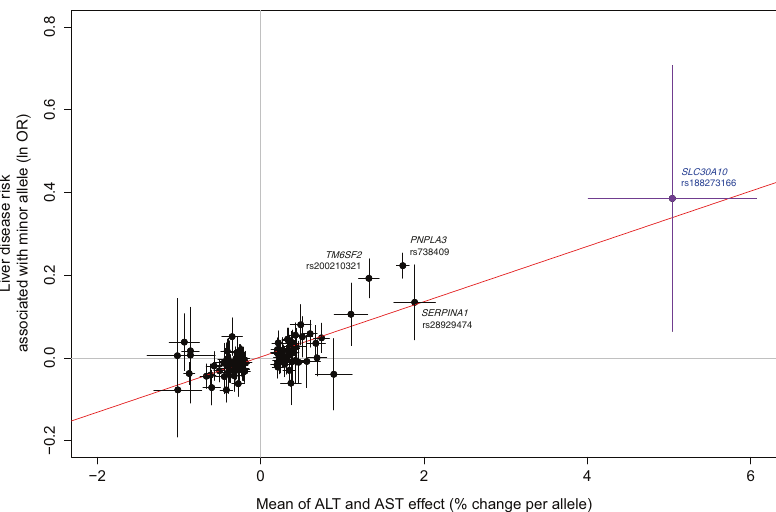
Fig. 3 Comparison of effect of lead variants on ALT and AST with effect on liver disease. Effect sizes (beta from the regression of units of log 10 ALT and AST, equivalent to percent change; and beta from the liver disease regression, equivalent to natural log of the odds ratio) are from PLINK analysis; error bars are 95% con fi dence intervals on these effect sizes from PLINK. Source data for this fi gure are in Supplementary Data